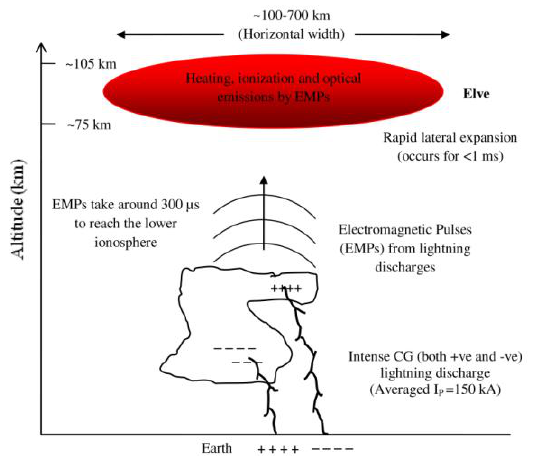
Fig. 5. Mechanism of Elves. Elves are produced by electromagnetic pulses from strong CG lightning return strokes. This figure is partly adapted from Rodger [80]